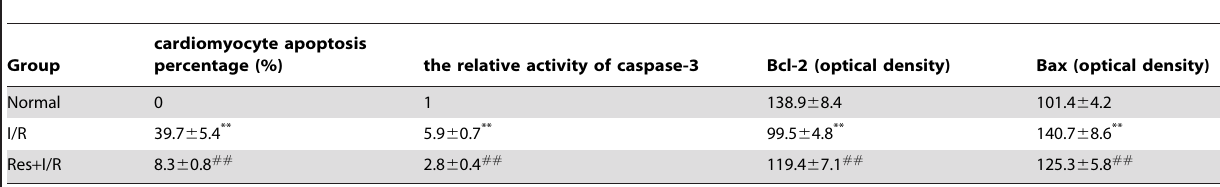
Table 2. Effect of Res on cardiomyocyte apoptosis percentage, the activity of caspase-3 and expressions of Bcl-2/Bax.